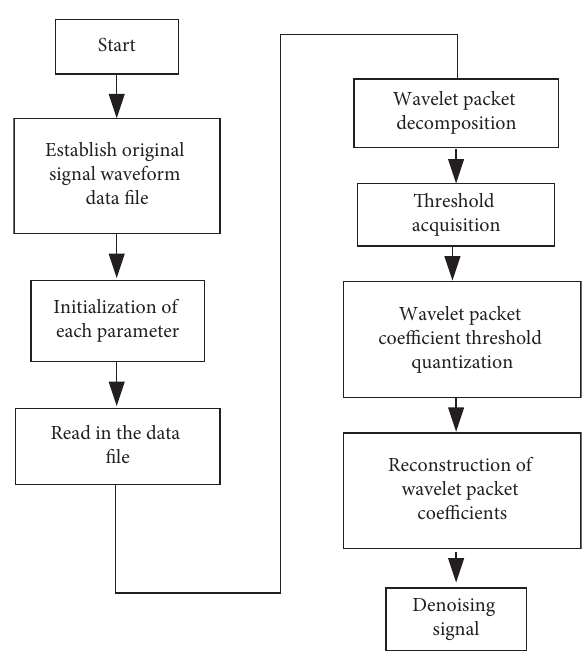
Figure 12: The calculating flow